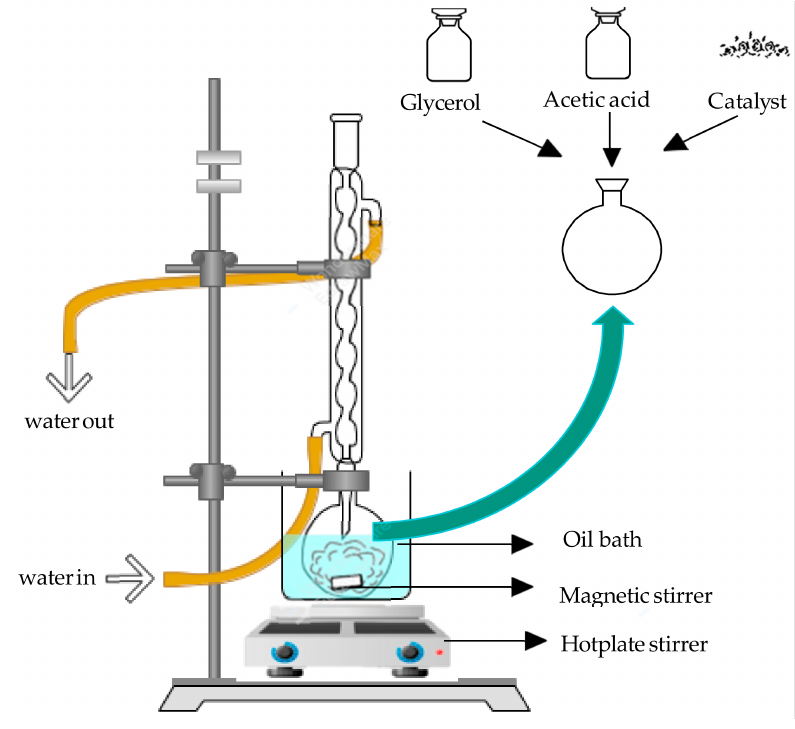
Figure 9. Experimental setup for glycerol acetylation using reflux